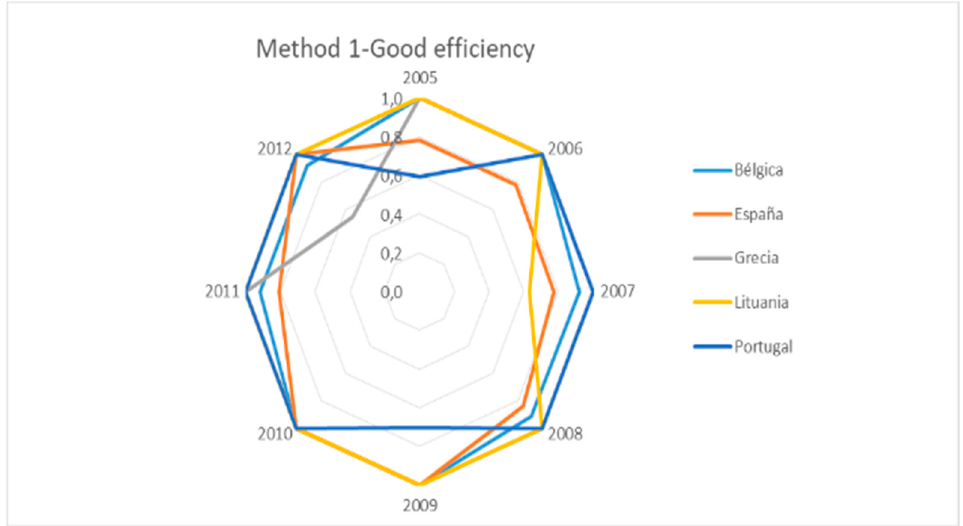
Figure 6. Variation in environmental efficiency in the years 2005–2012 with the DEA Method 1 and for Method 2 for the 14 countries in the category “Excellent environmental efficiency”. Source: self